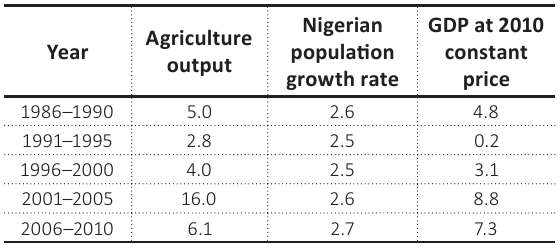
Source: World Bank (2000).